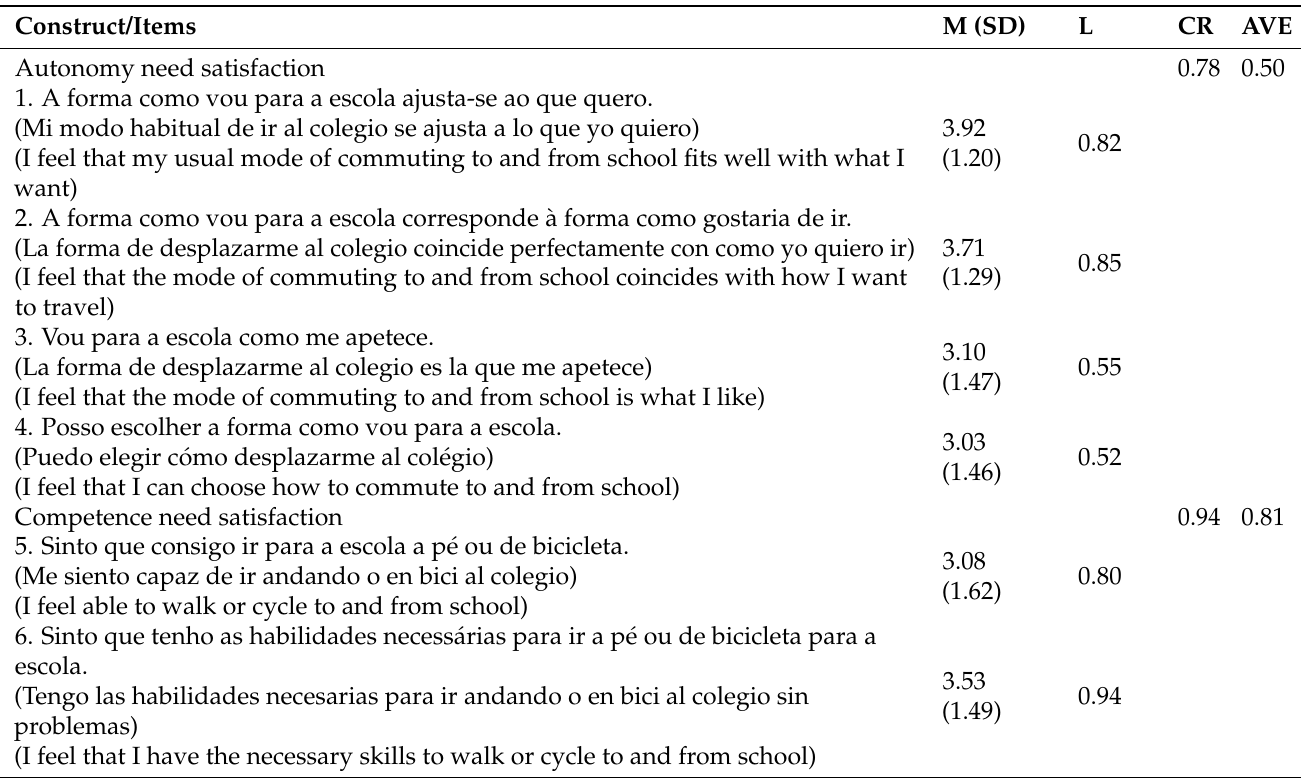
Table 1. Means and standard deviations, factor loadings; construct reliability; average variance extracted; and correlations among constructs.